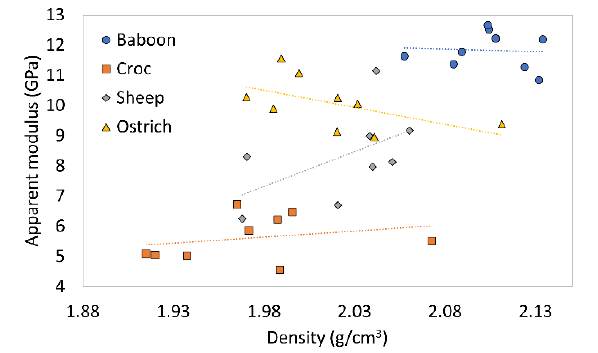
Figure 4 : Graph showing the variation of apparent modulus with